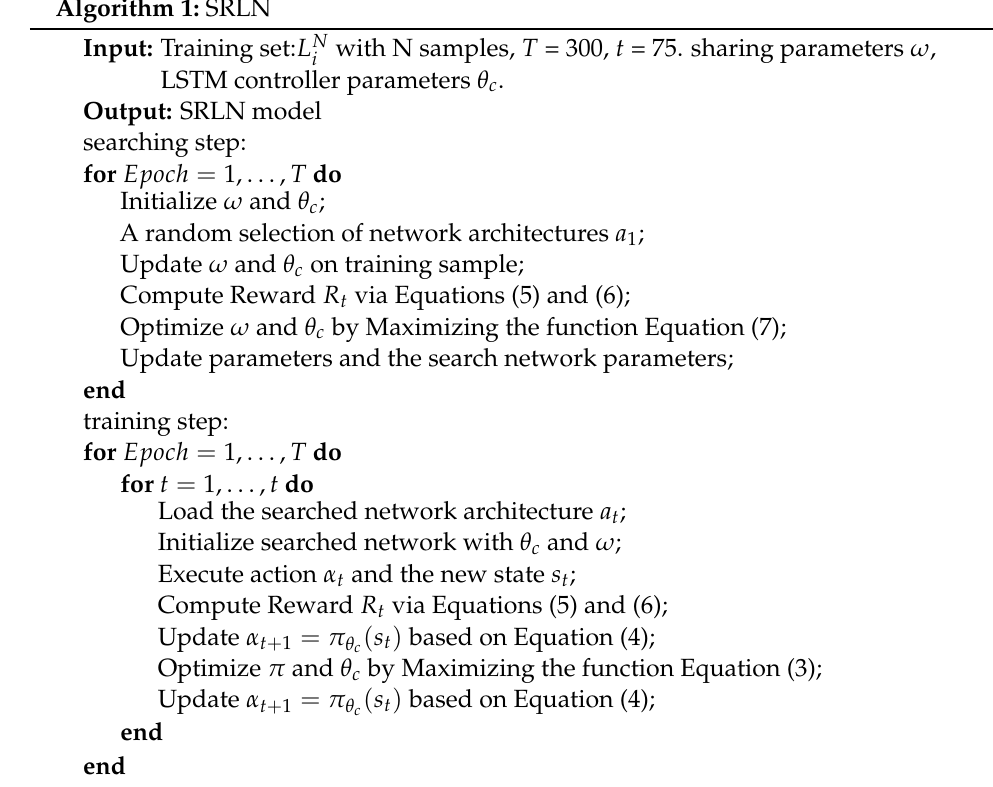
Algorithm 1 details the training procedure of our shooting reward learning network (SRLN). Algorithm 1: